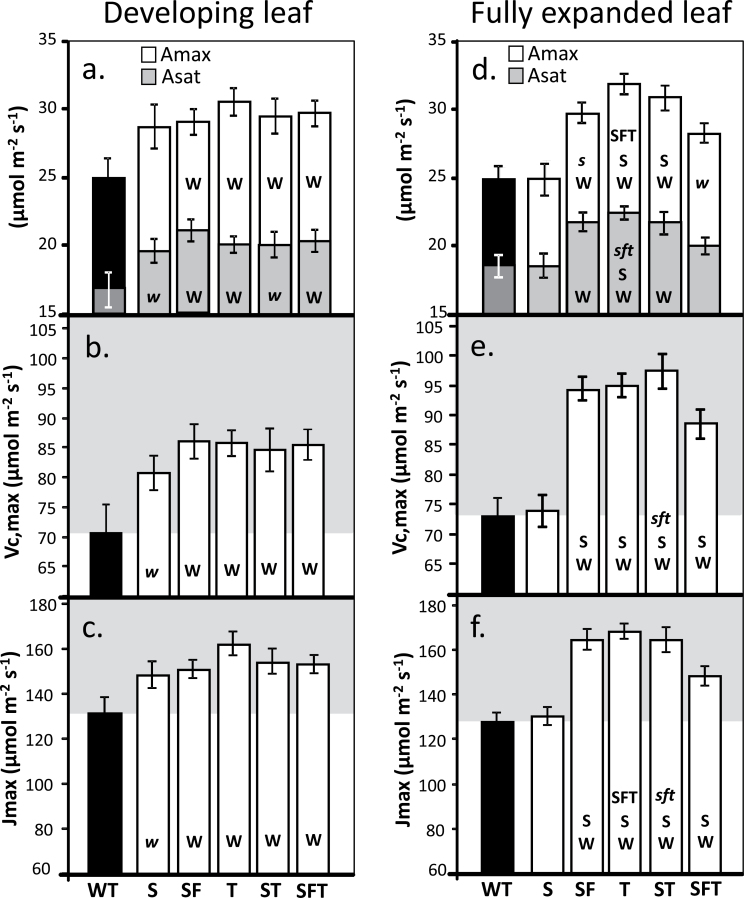
Rubisco activity and J
max derived from A/C
i response curves. These data are derived from the A/C
i response curves shown in Fig. 3 using the equations published by von Caemmerer and Farquhar (1981). Developing leaves (12cm leaves) and fully expanded leaves are shown. Values represent four plants from 3–4 individual lines (12–16 plants) for each transgene set. Lines over-expressing SBPase (S), SBPase and FBPA (SF), ictB (T), SBPase and ictB (ST), and SBPase, FBPA, and ictB (SFT) are represented. Significant differences (<0.05) are represented by capital letters. Lower case italic lettering indicates lines that are just below significance (>0.05 and <0.1).